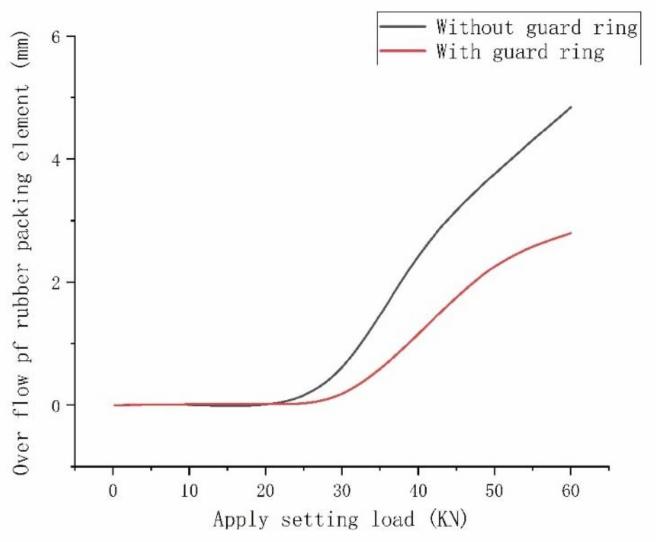
Figure 8. Comparison of rubber overflow with and without a guard